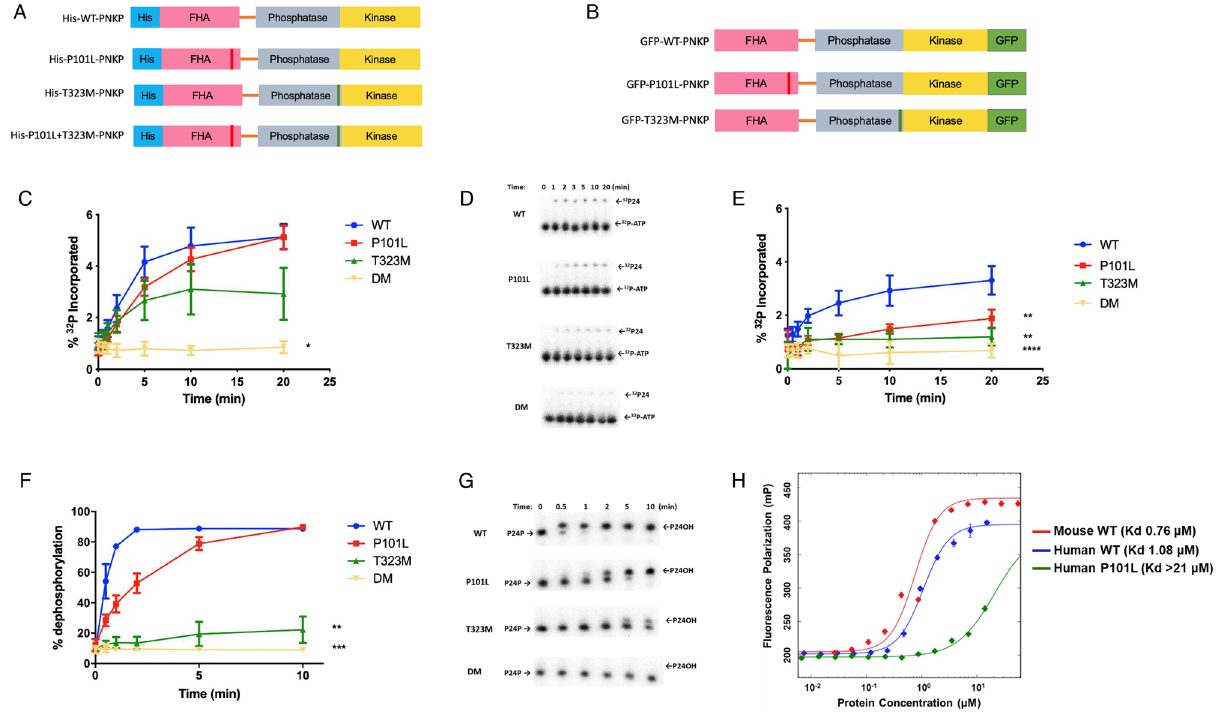
Figure 2. Measurement of 5 ′ -kinase and 3 ′ -phosphatase activities of wild-type and mutant PNKPs. ( A , B ) The structures of mutant PNKP constructs designed to monitor the effects of the PNKP mutations found in the MCSZ patient. FHA represents the forkhead-associated domain of PNKP. His-indicated histidine tag ( A ) and GFP indicates the green fluorescent protein tag ( B ). ( C ) Kinase assay: a 24mer oligonucleotide bearing a 5 ′ -hydroxyl terminus was incubated with wild-type or P101L, T323M, and the double mutant (DM) variant PNKP proteins in the presence of a tenfold molar excess of radiolabelled ATP and then analyzed by gel electrophoresis. ( D ) Representative gel image of PNKP kinase assay. 32 P24: 24-mer oligonucleotide substrate bearing a 32 P-label at the 5 ′ -terminus. 32 P-ATP: 32 P-labelled ATP ([γ- 32 P] ATP). ( E ) To examine the temperature-dependent destabilization of wild-type and mutant forms of PNKP, the proteins were preincubated at 37 °C before carrying out the kinase assay. ( F ) Phosphatase assay: a 5 ′ -labelled 24-mer oligonucleotide bearing a 3 ′ -phosphate group was incubated with wild-type or variant PNKP protein and then analyzed by gel electrophoresis. ( G ) Representative gel image of PNKP phosphatase assay. P24P: 24-mer oligonucleotide substrate bearing a 32 P-label at the 5 ′ -terminus as well as a 3 ′ -phosphate. P24OH: 24-mer oligonucleotide substrate bearing a 32 P-label at the 5 ′ -terminus, and 3 ′ -hydroxyl. ( H ) Interaction of wild-type and P101L PNKP with an XRCC4-based peptide. The interaction was monitored by fluorescence polarization of the fluorescent-dye labeled XRCC4-based phosphopeptide (GGYDES-pT-DEESKK) in the presence of increasing concentrations of wild-type murine and human wild-type or P101L PNKP. In each case the data represent the mean ± SEM of three independent experiments. Ordinary one-way ANOVA followed by Tukey’s multiple comparisons test was performed using GraphPad Prism 7.0, GraphPad Software. *p < 0.05, **p < 0.01, ****p <